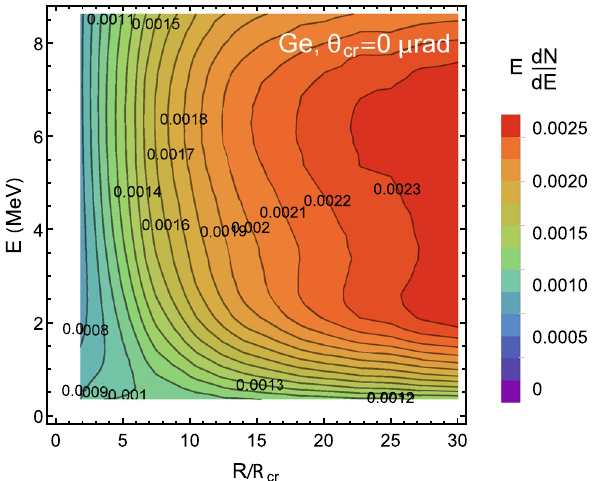
Fig. 7 Simulated radiation spectral intensities vs the ratio of the bend- ing radius to its critical value for the Ge bent